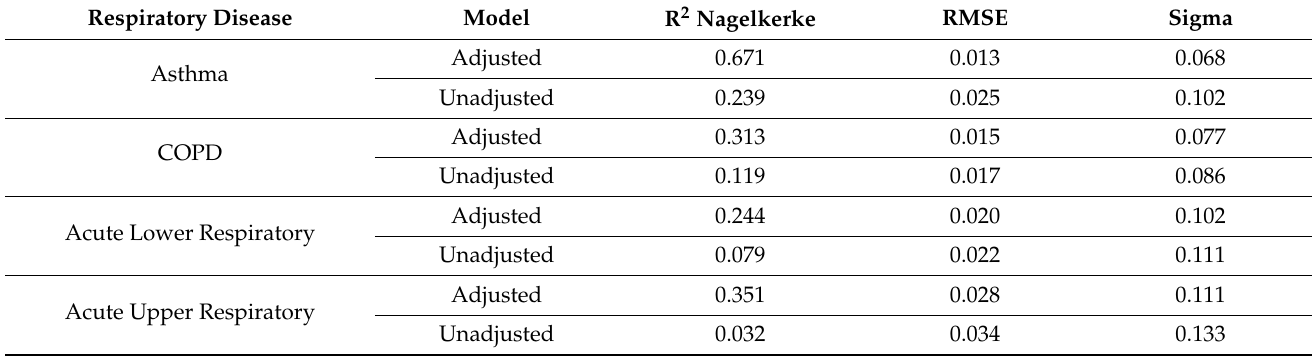
Table 6. Comparison of the adjusted models with the unadjusted